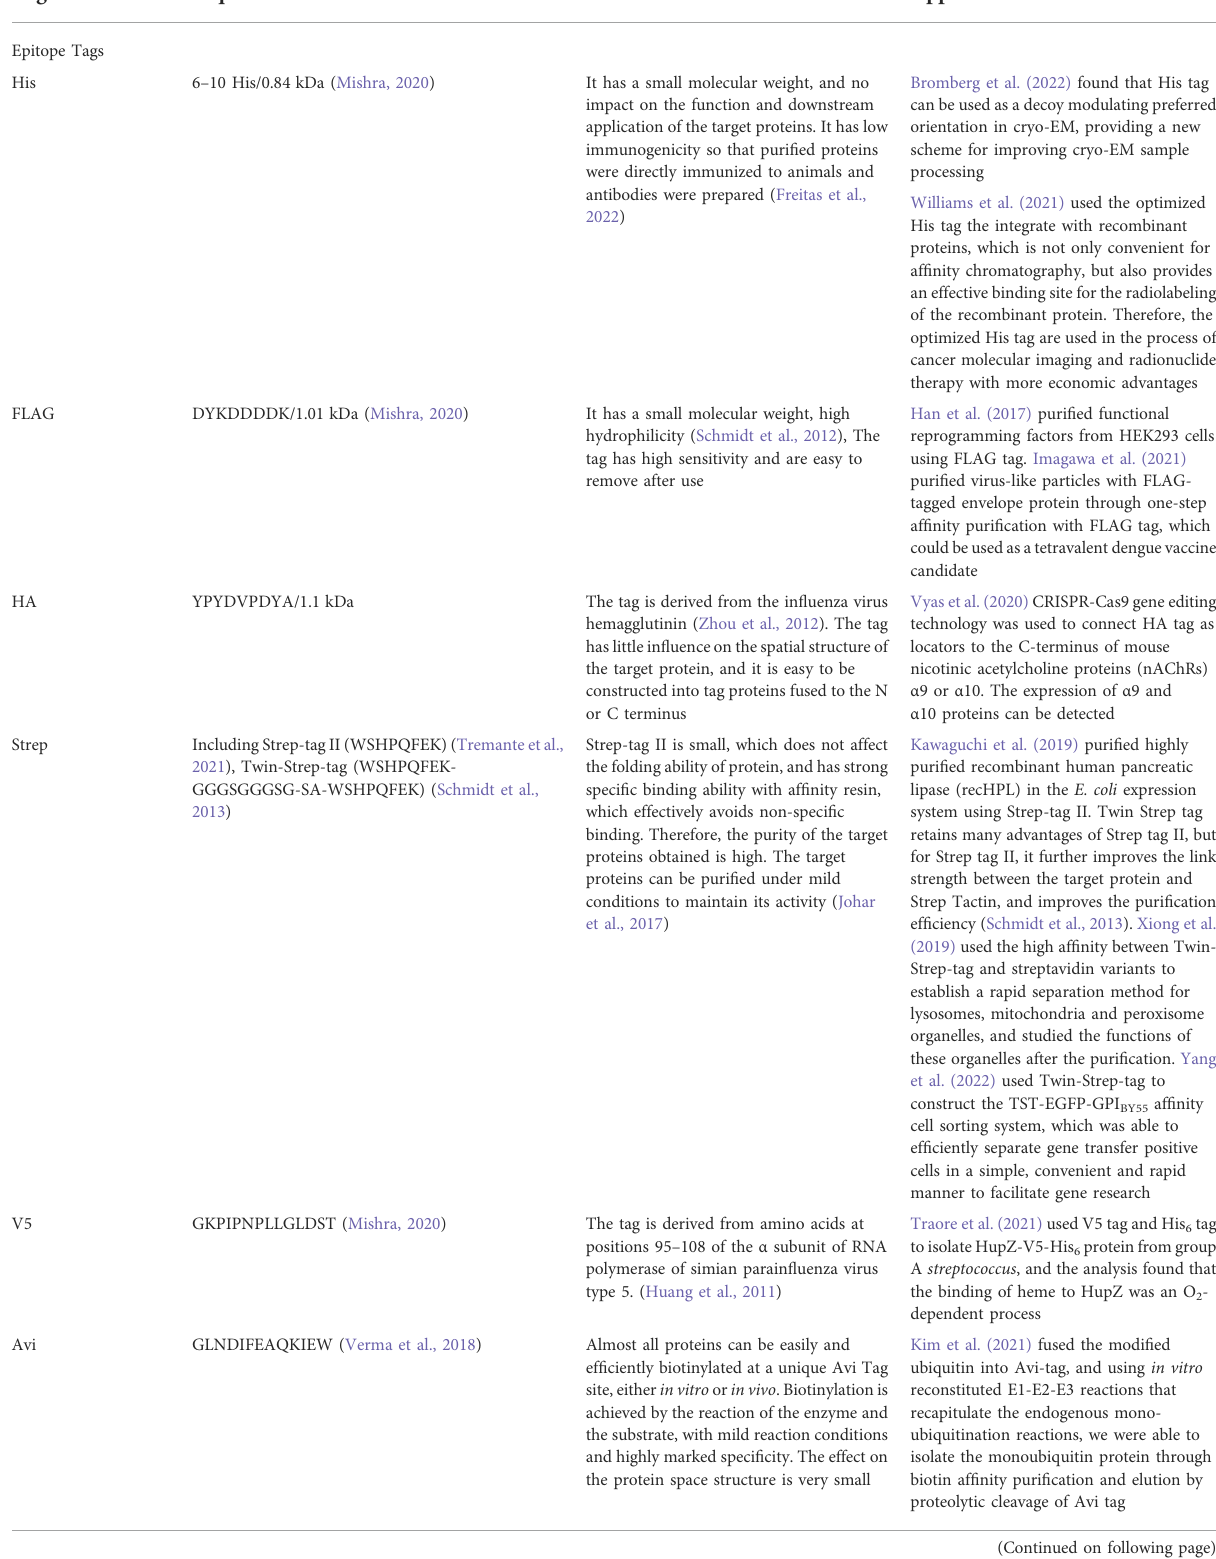
TABLE 6 Characteristics and applications of the common af fi nity